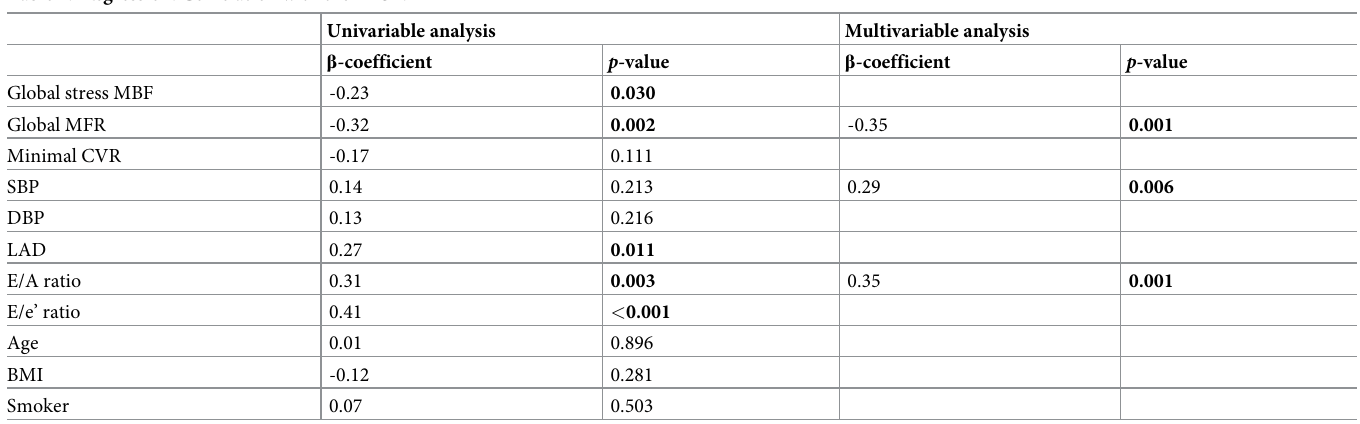
Table 4. Regression: Correlation with the